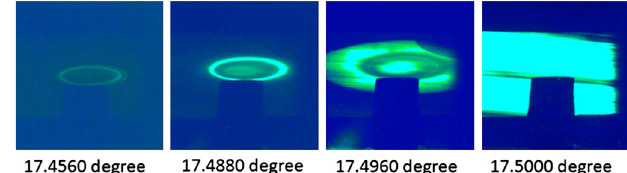
FIG. 10. Various diameters of the regions of interest from the XRD CCD snapshots. The white dotted line is the diameter over which data was sampled for Fig.